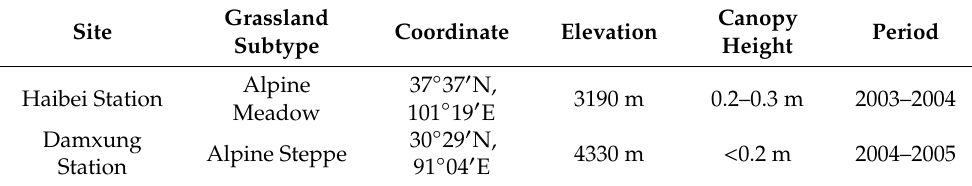
Table 2. Descriptions of the two flux sites used in this